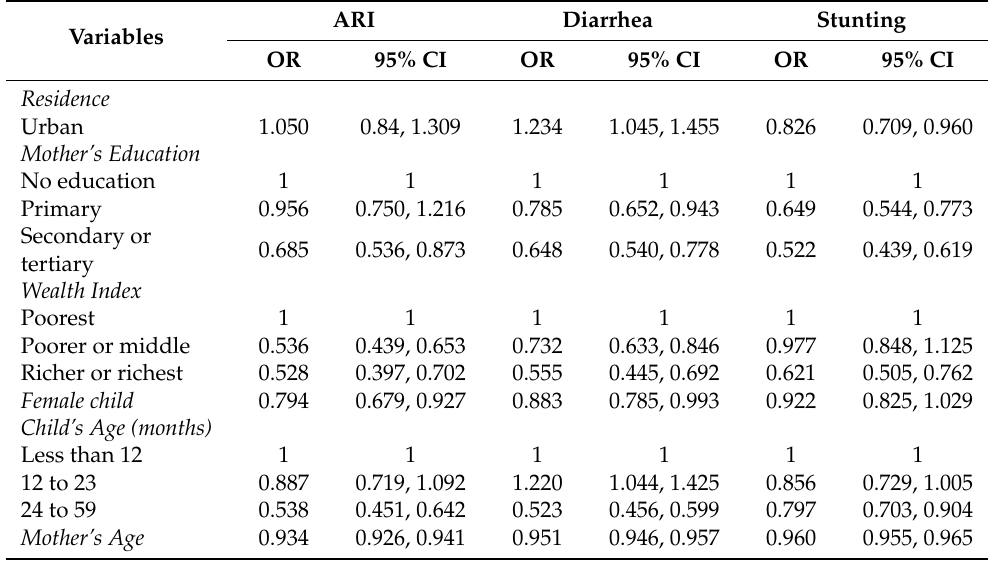
Table 6. The odds ratio estimates of covariate effects and their 95% Credible Interval for 2018. ARI Diarrhea Stunting Variables OR